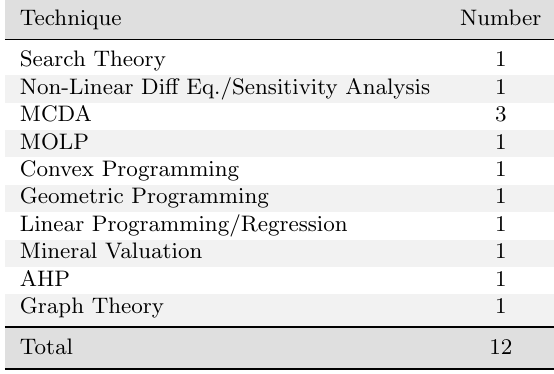
Table 4: A summary of the research techniques used in winning